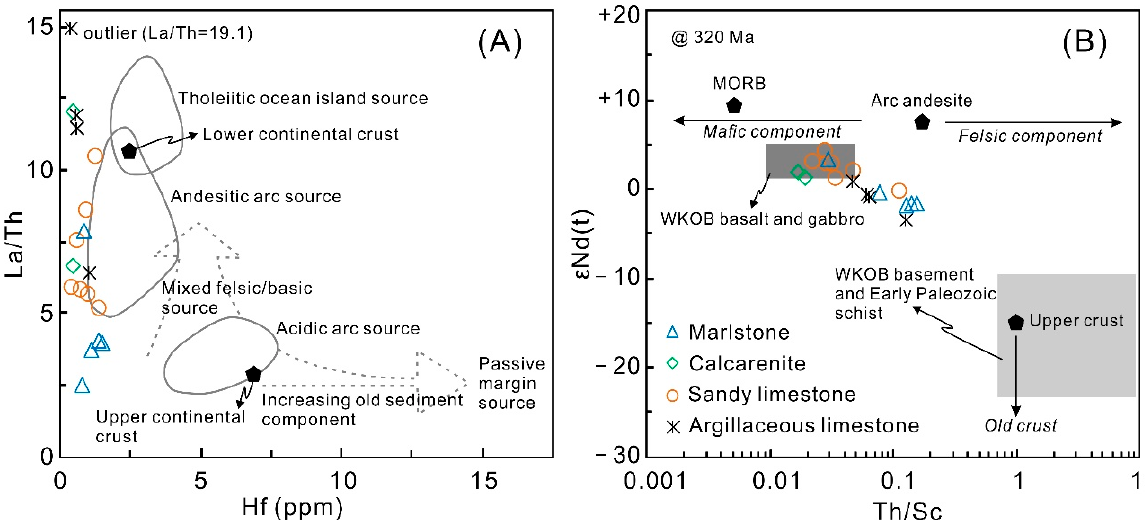
Figure 8. ( A ). Source rock discriminating diagrams for the non-mineralized wall-rock samples on La/Th vs. Hf (modified after [109]). Average reference compositions are from [111]. ( B ). ε Nd(320 Ma) vs. Th/Sc diagrams of the non-mineralized wall-rock samples. End member compositions are from [101]. Data sources are from [63,71,104,105].